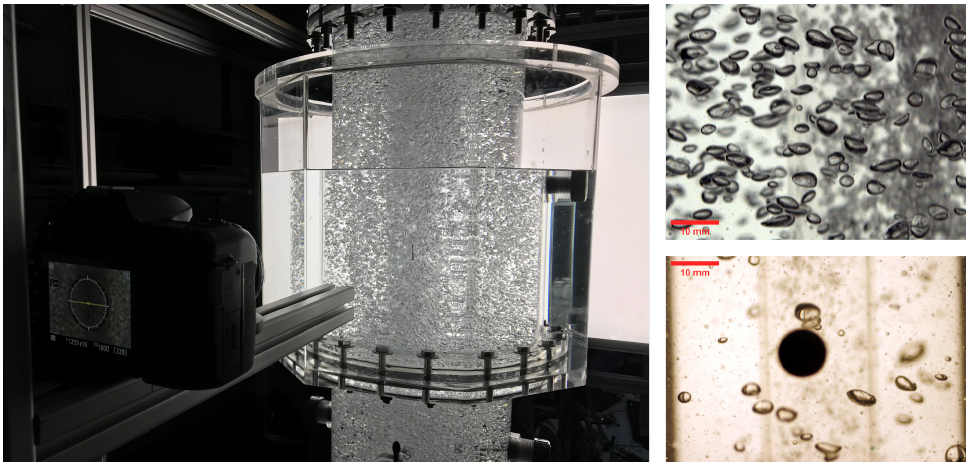
Figure 4. ( Left side ): Pilot-scale reactor with the installed aquarium for refractive index matching; the camera is in the foreground, while the LED panel, which provides a homogeneous background illumination, is located on the opposite side. ( Right side ): exemplary photos of bubble collectives for V l · ˙ V − 1 g = 17.0 min and (cid:101) = 4.0 kW m − 3 in the pilot ( top ) and laboratory reactor ( bottom